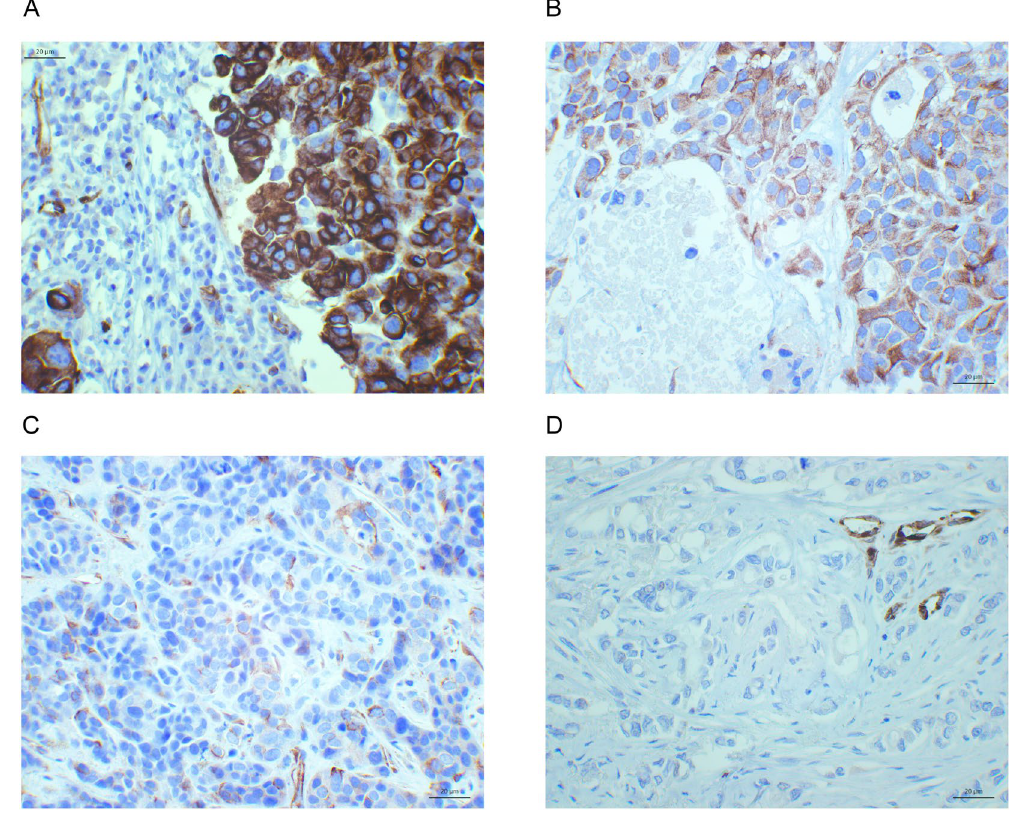
Figure 1. Nestin protein expression by immunohistochemistry. Nestin protein expression, strong ( A ), moderate ( B ), weak ( C ) and negative ( D ), in breast cancer tumour cells, with some positive tumour vessels in D